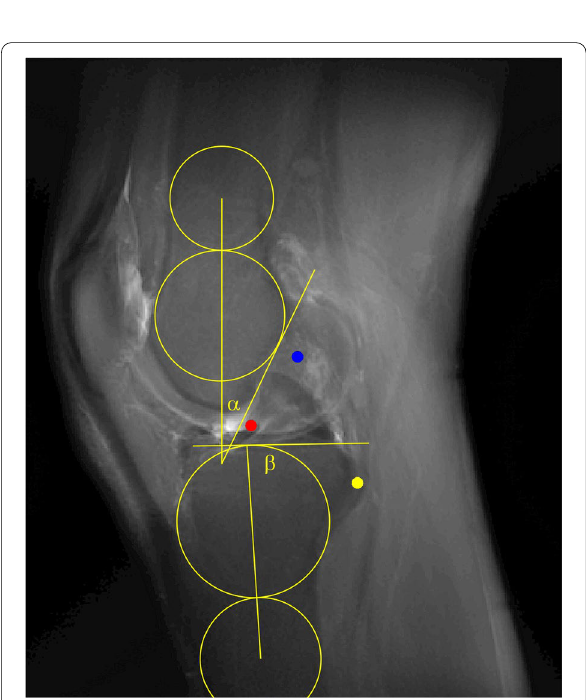
Fig. 3 femoral intercondylar notch roof angle ("α"), proximal tibial slope